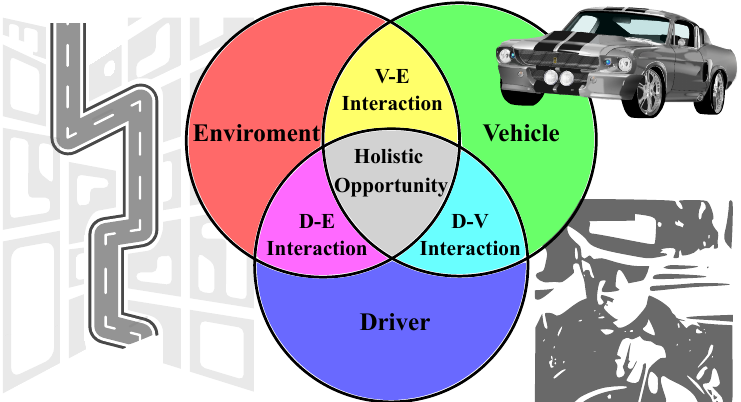
Figure 1. Main elements involved in a road safety system: environment, vehicle, and driver. Inter- actions between these elements: vehicle–environment (V–E) interaction, driver–environment (D–E) interaction and driver–vehicle (D–V) interaction. At the center is reflected the holistic relationship between elements and the opportunity in the C-ADAS